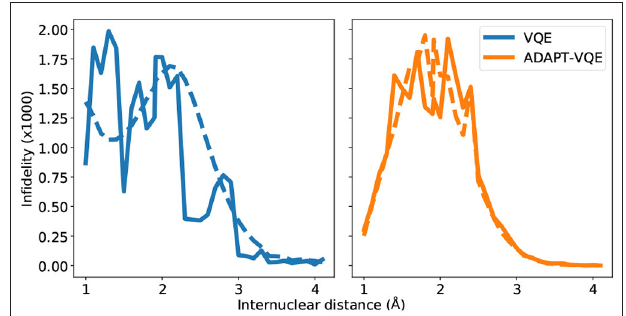
FIGURE 7 | State infidelities for VQE and ADAPT-VQE using COBYLA (solid line) and L-BFGS (dashed line) optimization with central finite differences for the NaH potential energy